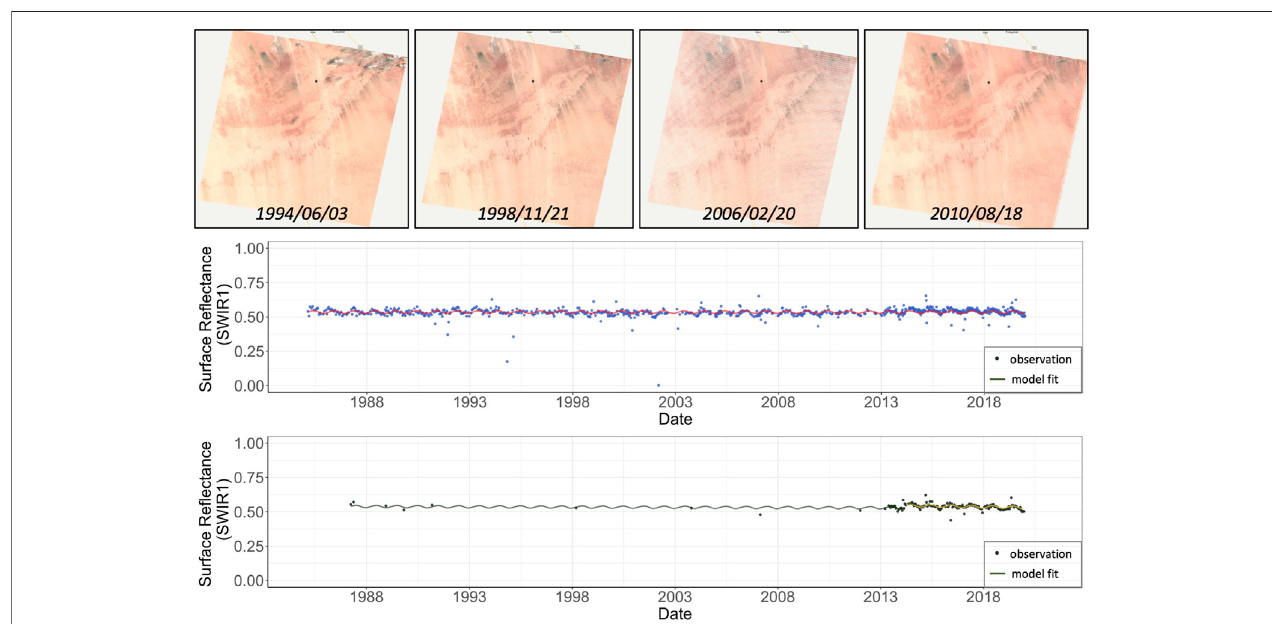
FIGURE8| Thetimeseriesplotofusingover- fi lteringAOTobservations(lowerpanel)versustheregularAOT fi lteringstrategy(middlepanel)andexampleofusable Landsat images (upper panel). No saturation fi ltering was applied here.